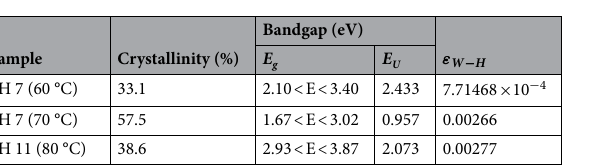
Table 4. Comparison of the crystallinity, Tauc bandgap, Urbach energies and W–H strains for all samples.